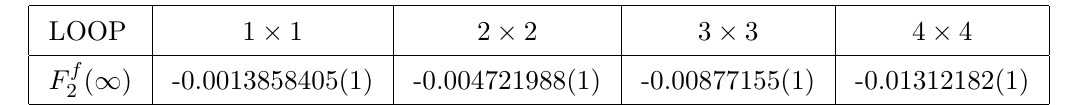
( (cid:20) c ; 1 ) de(cid:12)ned in the text for massless r = 1 2